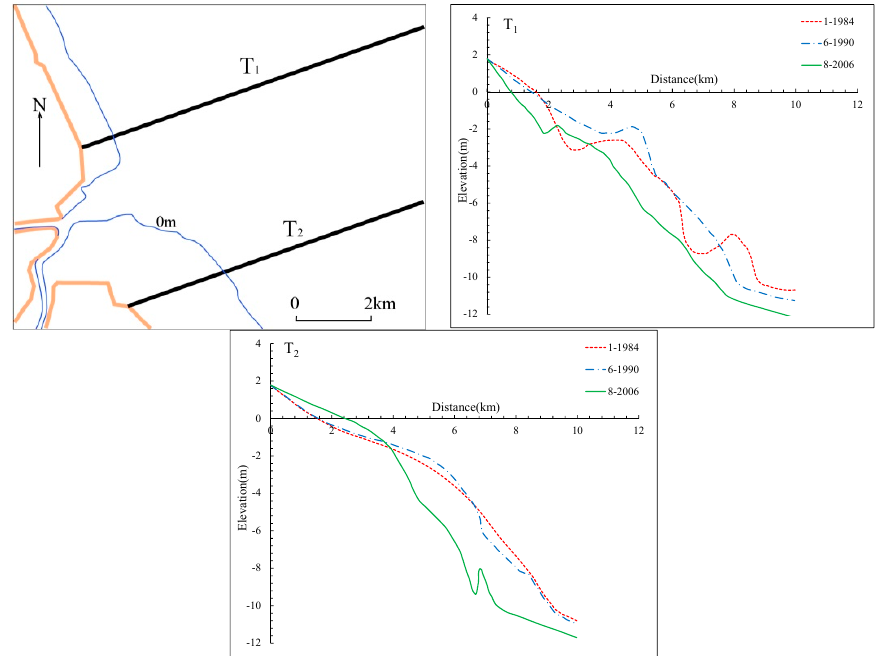
Figure 2. Two topographic transects spanning 1984–2006 at the north and south sides of the Sheyang River mouth. The 0 m isobath is depicted for the year of 2006 (datum is above MSL; the same hereinafter).